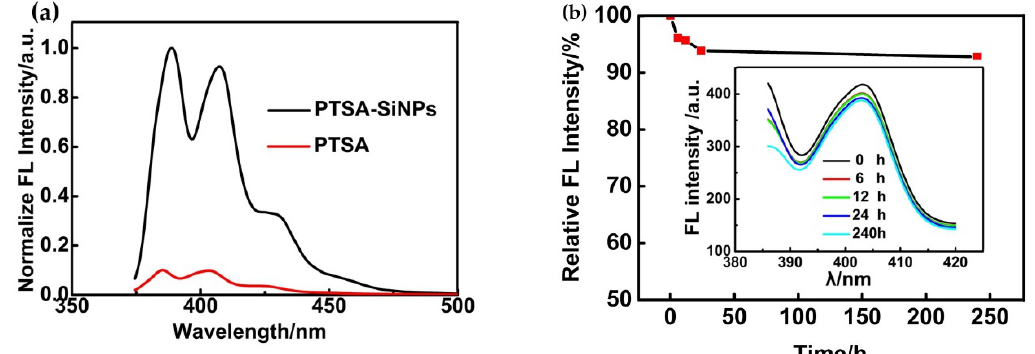
Figure 5. Fluorescence emission spectra of ( a ) PTSA-SiNPs and PTSA in H 2 O (concentration 10 − 5 M). Excitation of the two samples is at 376 nm. ( b ) The relative fluorescent intensity of the purified PTSA-SiNPs in H 2 O with the change in time (the insert image shows the fluorescence emission spectra of the purified PTSA-SiNPs in H 2 O at different times).